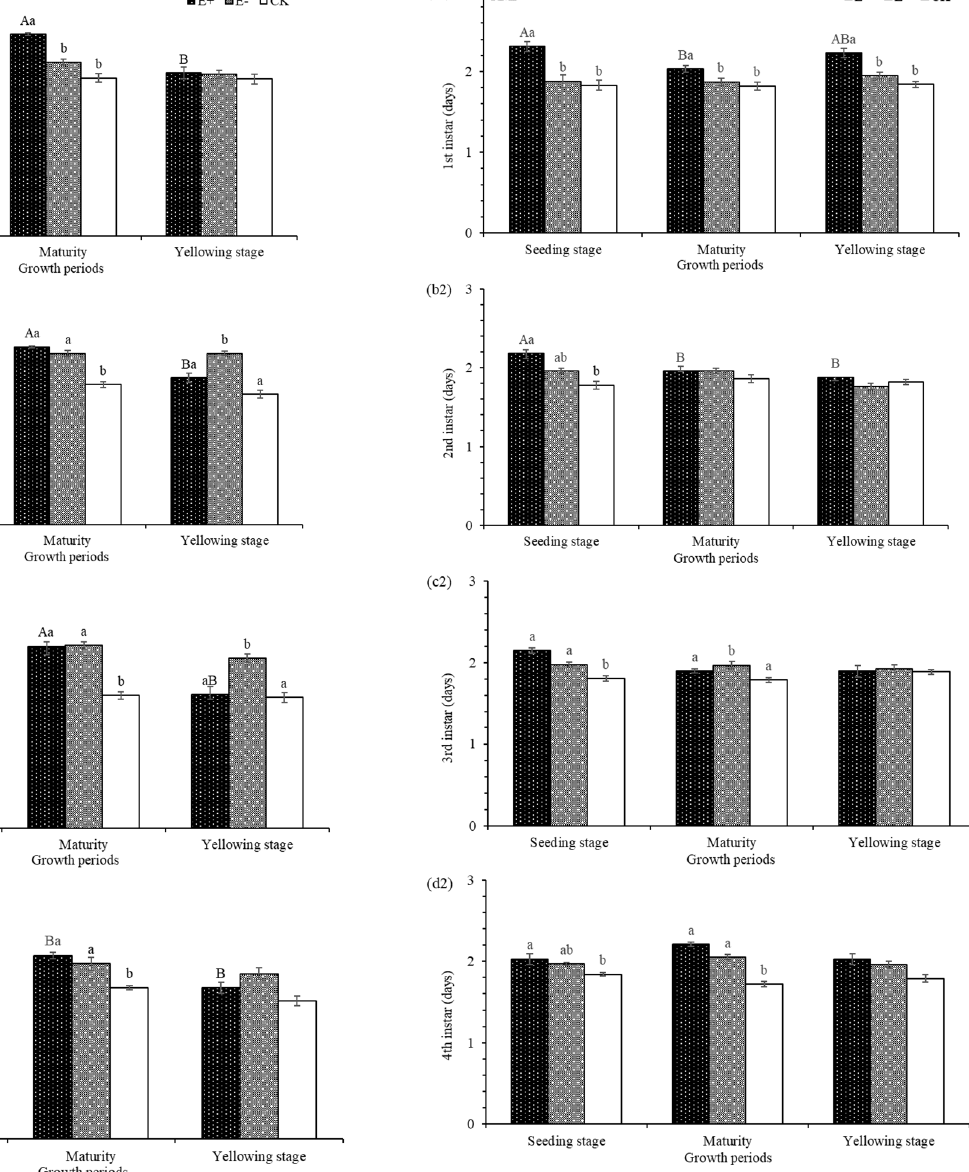
Figure 2. 1st instar, 2nd instar, 3rd instar, and 4th instar growth times in green color morphs of pea aphid (GMP) and red color morphs of pea aphids (RMP) treated with aqueous extracts of different growth stages of plants ( a1 , a2 , b1 , b2 , c1 , c2 , d1 and d2 ). E+, endophyte-infected A. inebrians ; E − , endophyte-free A . inebrians ; CK, control. Different capital letters indicate that there are significant differences between different growth periods/stages, and different small letters indicate that there are significant differences between treatments ( p <